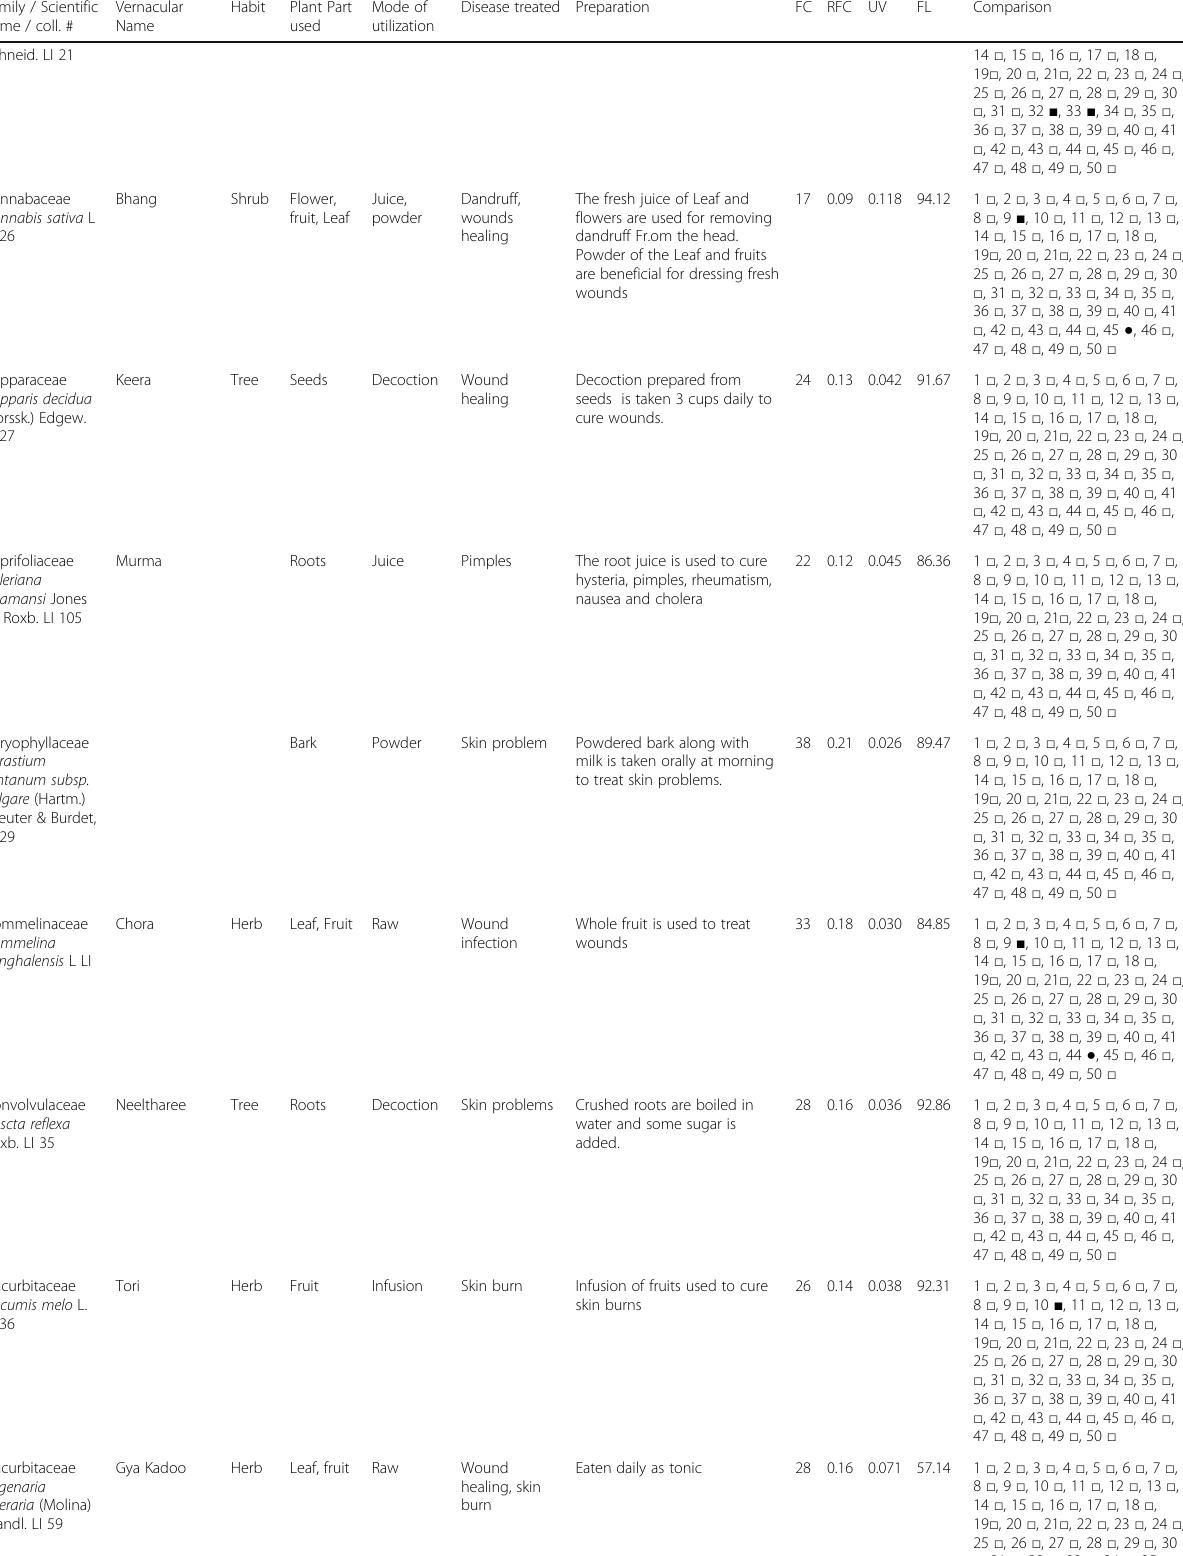
Table 2 Medicinal plants used for skin diseases in Northern Pakistan (Continued) Family / Scientific name / coll.